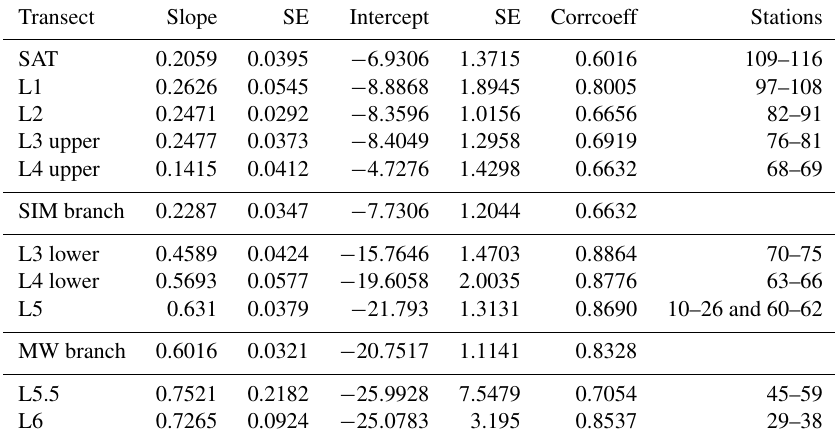
Table 1. Linear regression analyses (restricted to salinities ≤ 34.5) of salinity– δ 18 O measurements collected along transects occupied during 2013. Slopes, intercepts, correlation coefficients ( r ) and associated standard errors (SEs) are reported for each transect as well as the collection of transects comprising the sea-ice melt (SIM) and meteoric (MW) water